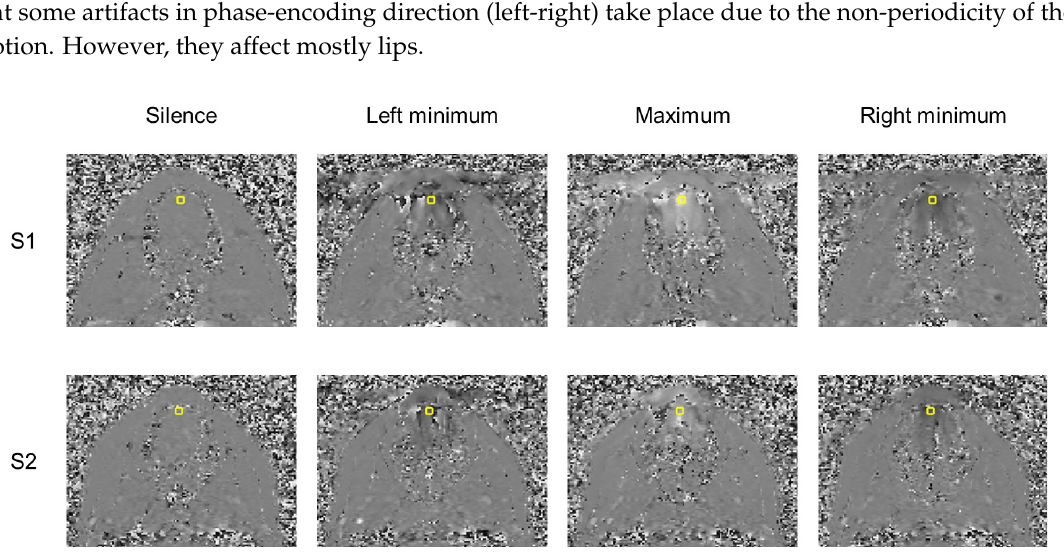
Figure 5. Examples of phase-contrast images acquired in the oblique plane for the initial position and the extreme tongue trajectory points which are presented in Table 1 for both subjects. Black color corresponds to − π and motion downwards and white corresponds to π and upwards. The yellow rectangle denotes the region of